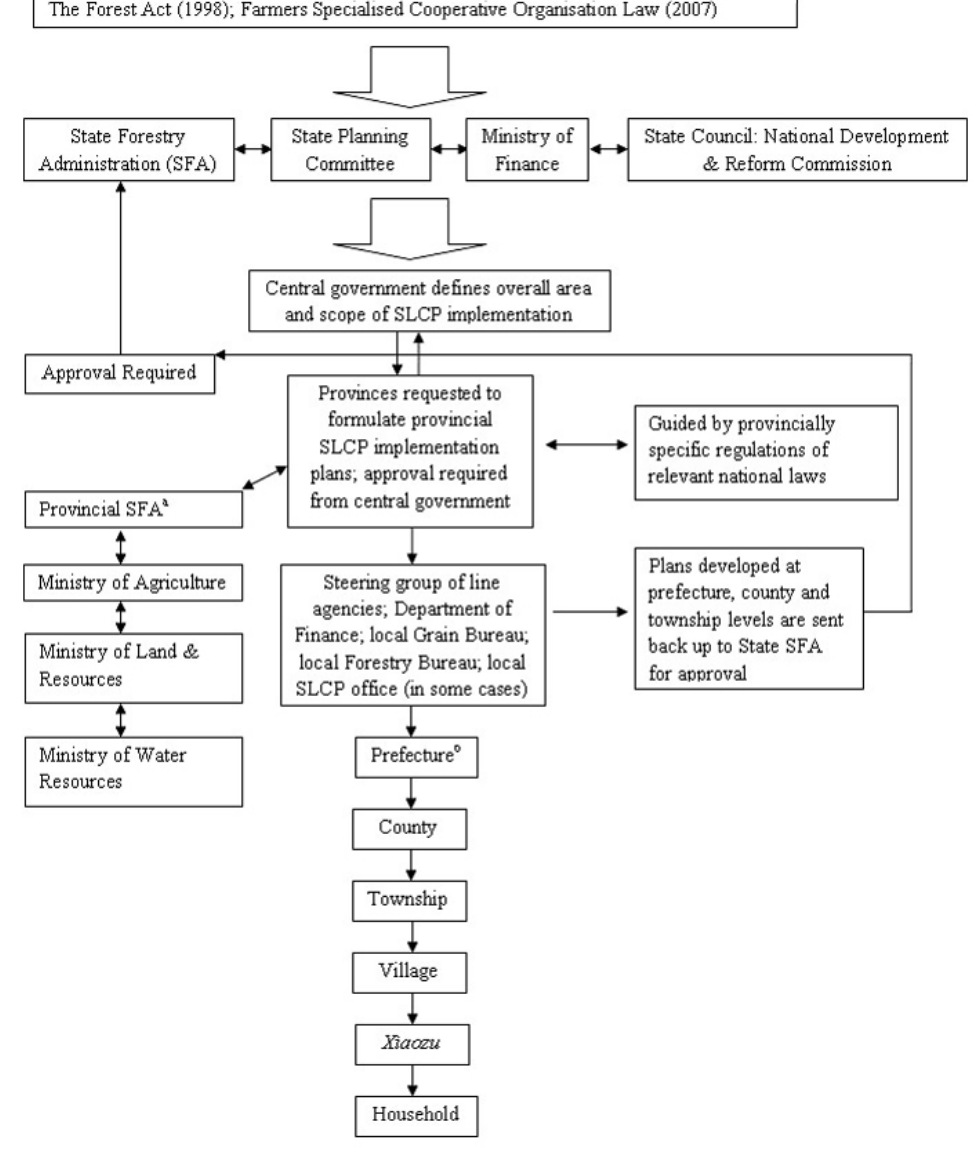
Fig. 1 . The Sloping Land Conversion Program’s (SLCP) complex administrative and implementation framework used to determine participation, target areas for inclusion, and distribute payments. Local practices and provincial decisions for implementation vary considerably. Sector-specific initiatives embedded within agency development strategies have typically not been analyzed and rectified for inconsistencies and gaps prior to roll out of the SLCP. Once approved, plans are sent back to prefecture level (9-20 per province); counties themselves have between 10-30 townships under their jurisdiction; 15-30 villages under each county, and groups of households called Xiaozu within each village that, rather than households, may hold actual proprietary or managerial rights to land (Agarwal and Ostrom 2001, Wang et al. 2004, Weyerhaeuser et al. 2005, Zhang et al. 2008; B. Lohmar, C. Nickerson, E. Uchida, and X. Jintao, unpublished manuscript